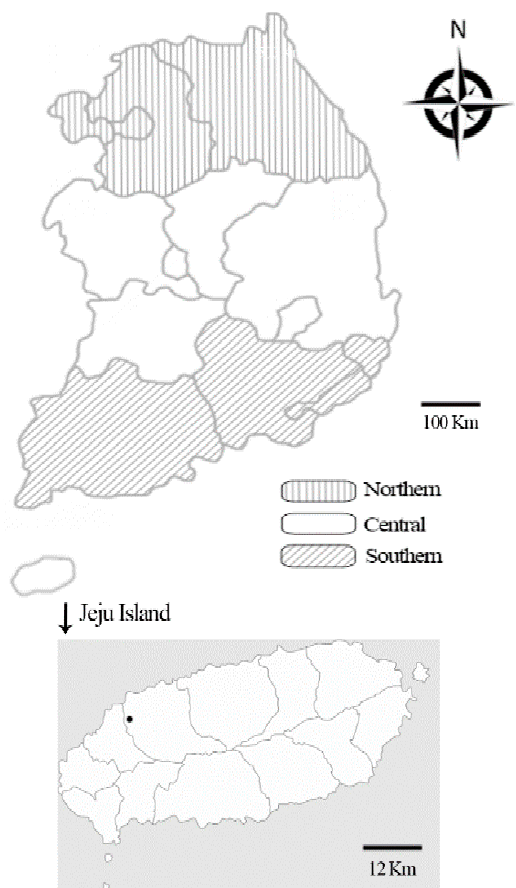
Figure 4. Map of the Republic of Korea. Horse blood samples were collected throughout the nation; however, lung tissue samples were only collected from Jeju Island. The dot denotes the location of the abattoir on Jeju Island from which the horse lung samples were collected. The regions of sample collection were divided into four groups: northern, central, southern, and Jeju Island.